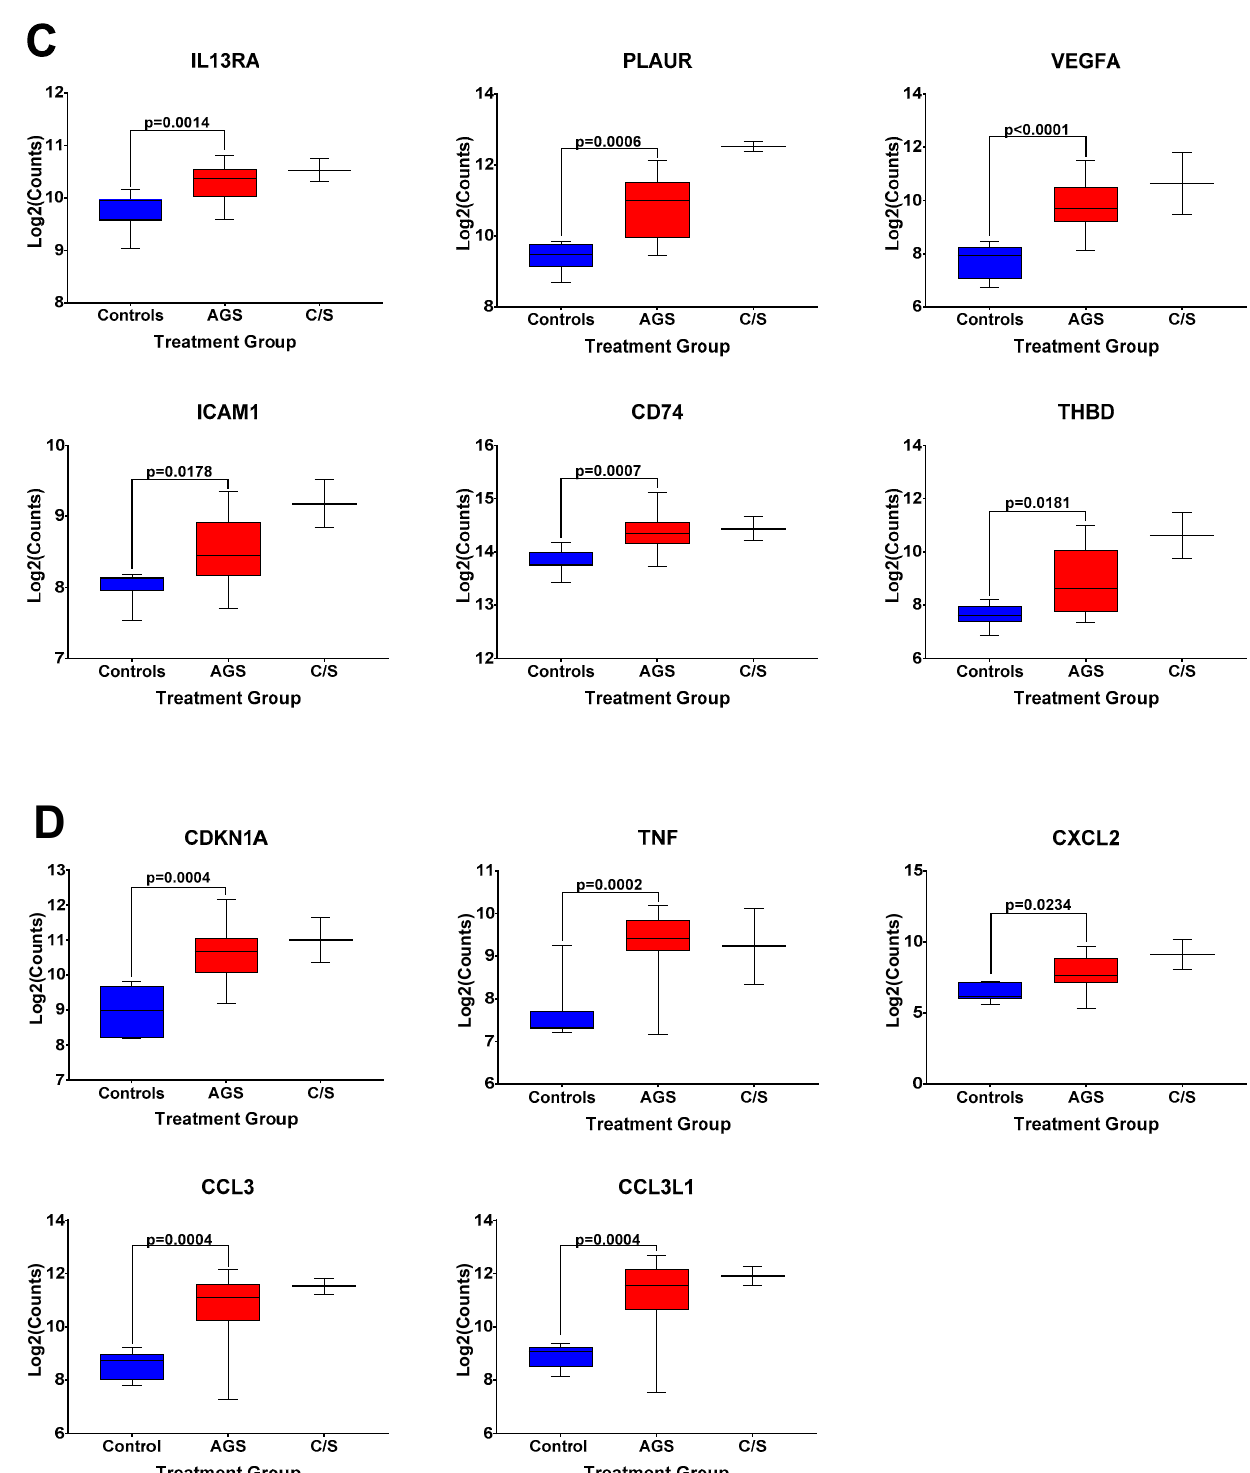
Figure 3. Normalized expression levels of selected immune response-related genes upregulated in PBMCs from AGS subjects compared to controls. ( A ) Genes involved in transcriptional regulation and/or the NFkappaB pathway. ( B ) Genes associated with antigen presentation and MHC II surface expression. ( C ) Genes associated with type 2/Th2 allergic immune responses. ( D ) Genes associated with itch and allergic dermatitis. p values were generated using an unpaired t test comparing AGS to controls, with p < 0.05 considered significant. Due to the small sample size, the sensitized but asymptomatic (“C/S”) group was excluded from statistical analysis. AGS = alpha-gal syndrome.